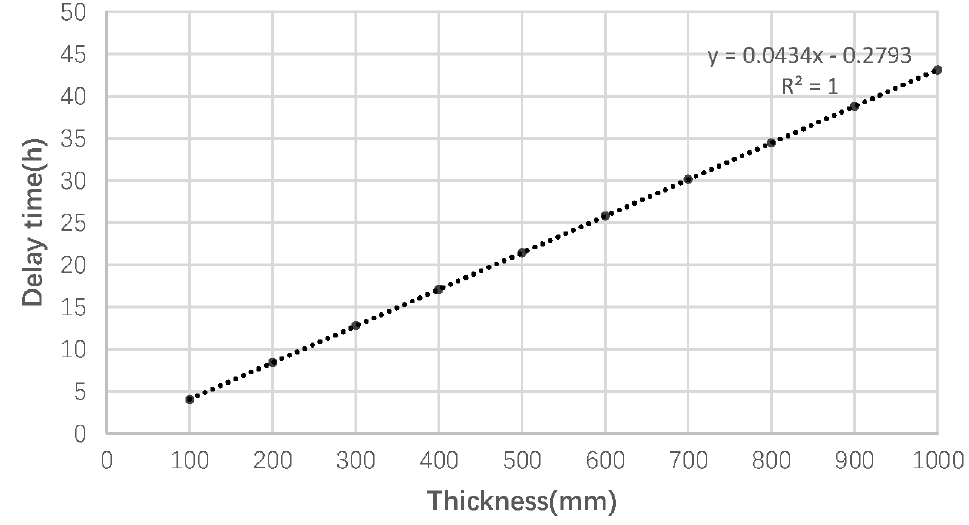
Figure 9. Fitting of the time lag.